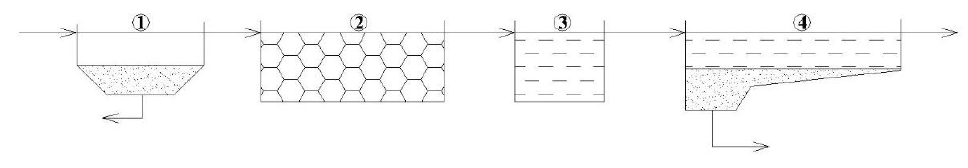
Figure 4. Two-stage nitrification system: 1 — PC; 2 — TF; 3 — ASRN; 4 — SC.